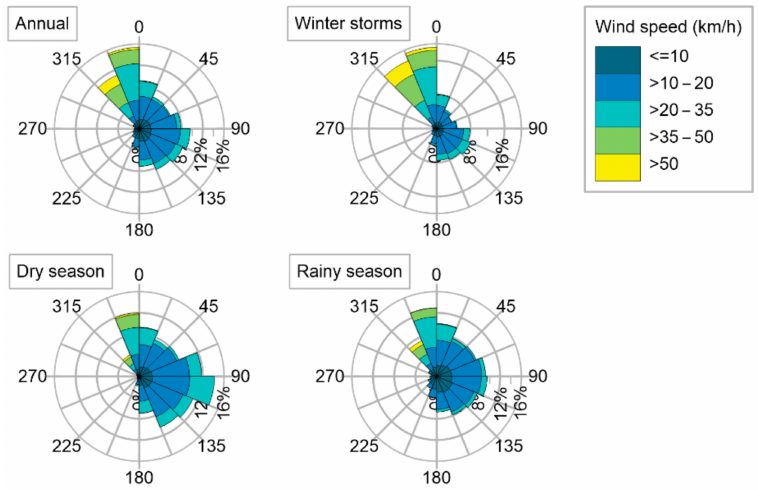
Figure 4. Annual and seasonal wind roses for La Mancha, data from Era5 [23]. Waves Wave roses (Figure 5) for the 19.5 ◦ N 96 ◦ W coastal cell, obtained from the Era5 database [23], show that the most energetic waves come from the NE, with a 30% frequency and heights of 0.5–1 m. In winter, waves approach from the NE, with heights of 1–1.5 m, and the highest wave heights come from the NW (315 ◦ to 360 ◦ ). Overall, the highest wave heights occur during winter storms, and the lowest values are in the dry and rainy